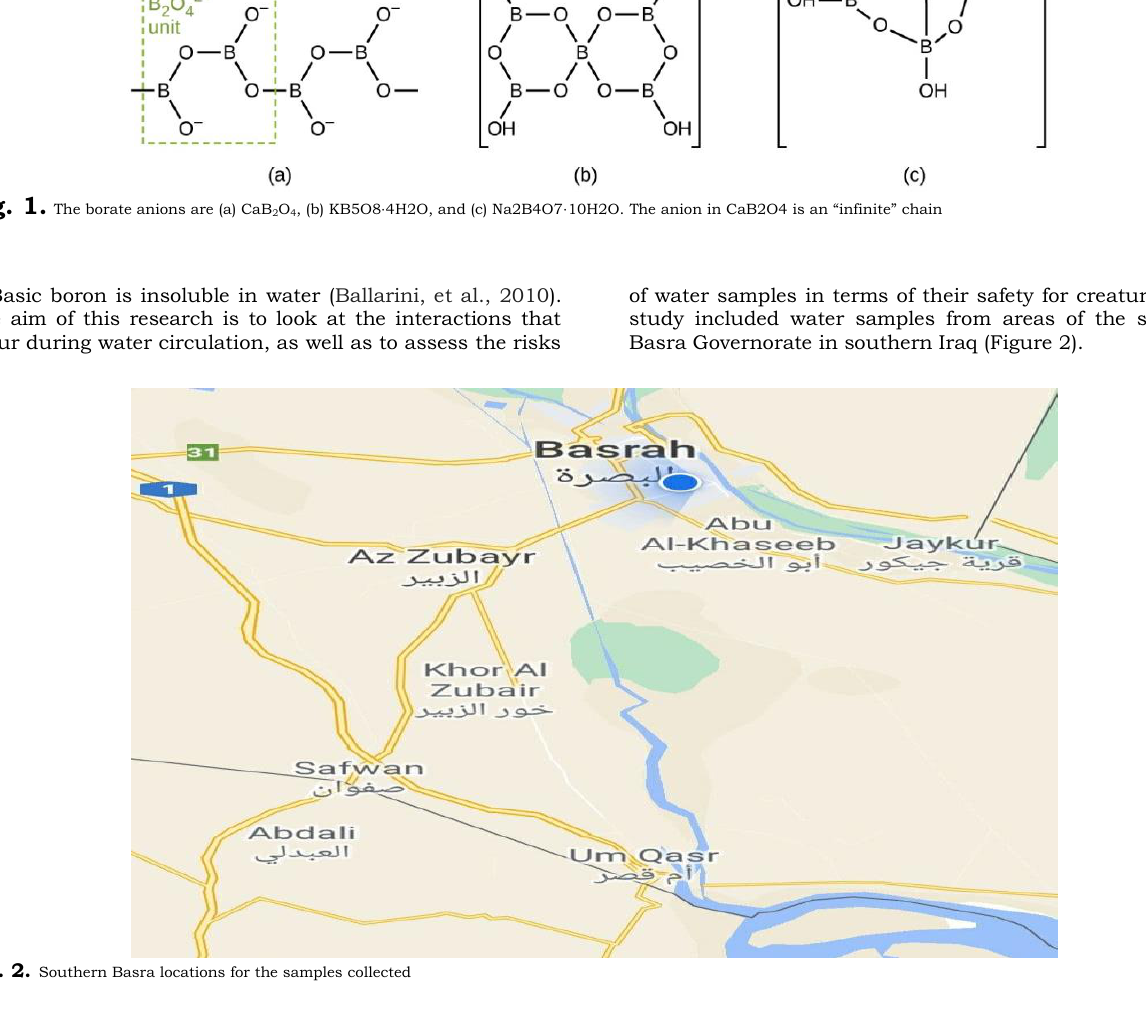
Fig. 2. Southern Basra locations for the samples